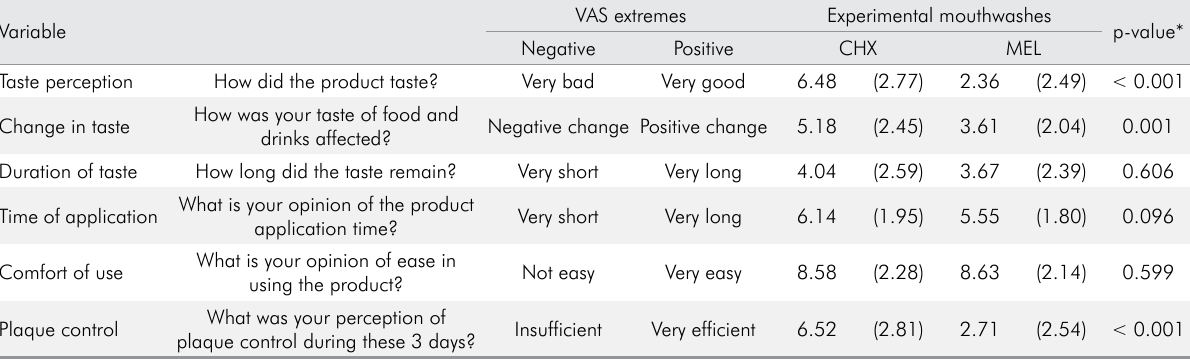
Table 2. Complete set of questions from Visual Analogue Scale questionnaire for taste perception, change in taste, and perception of biofilm control (scored from 0 to 10) (n =